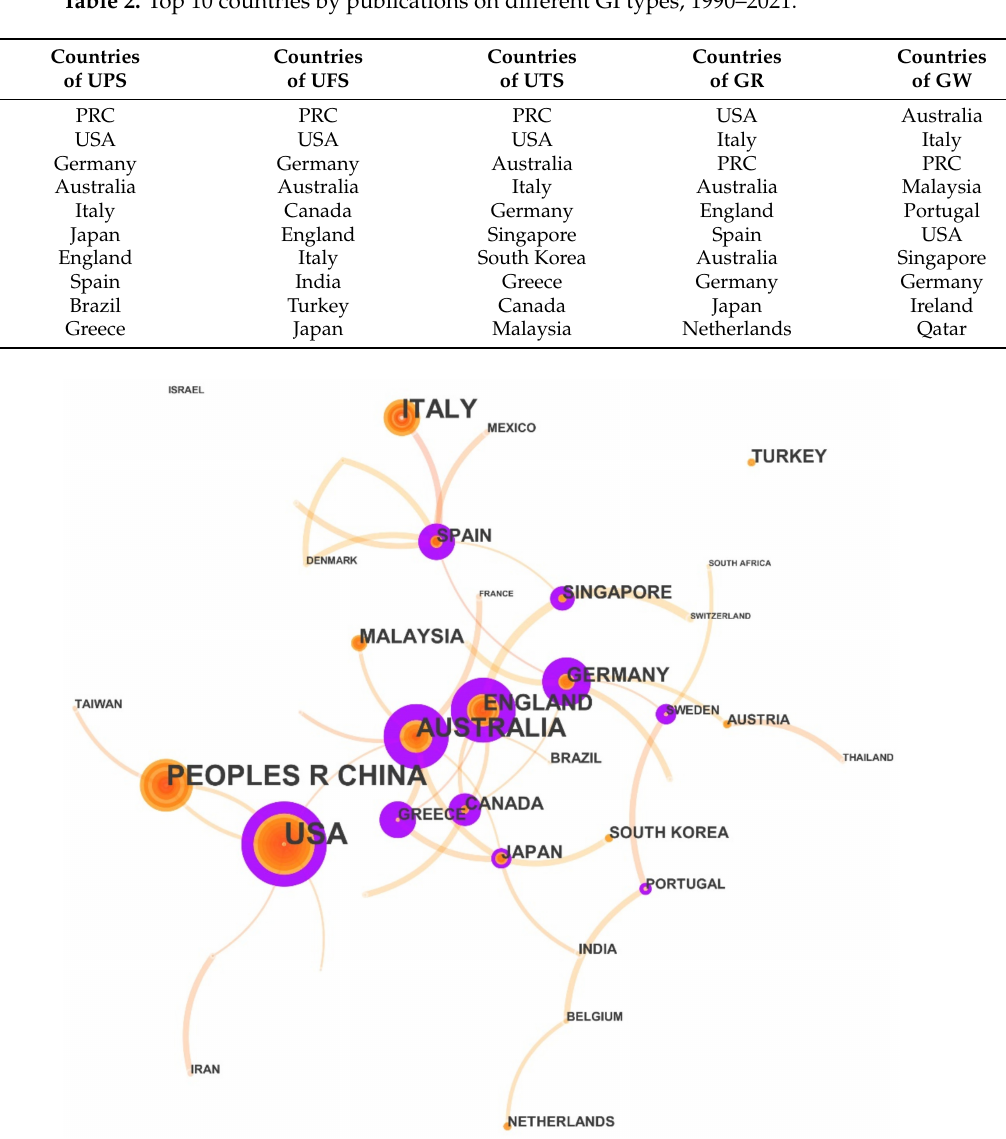
Figure 6. Distribution of main